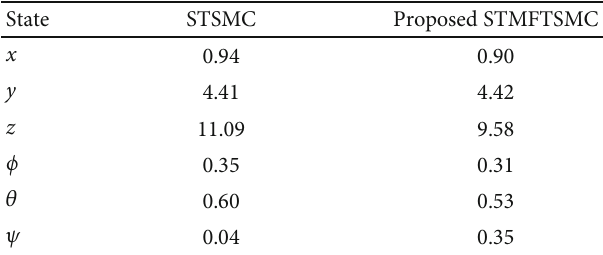
Table 3: IAE performance